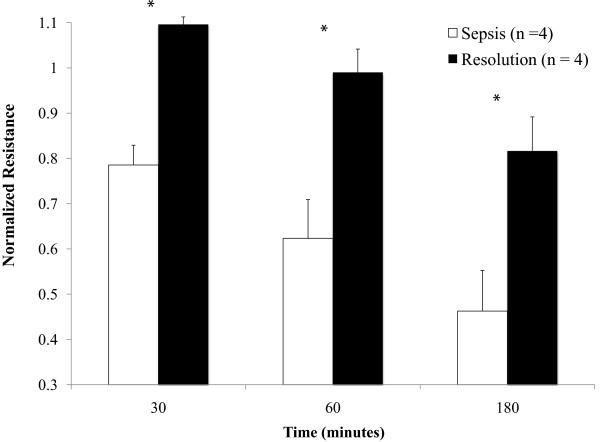
Resolution of sepsis leads to improved barrier function. Change in monolayer resistance at 30 minutes, 60 minutes, and 180 minutes. Groups were analyzed using two-way repeated-measures analysis of variance with Holm–Sidak post-hoc analysis. Values presented as mean ± standard error of the mean. The barrier-altering effect of neutrophils obtained once sepsis had resolved was significantly less than the effect of those obtained from the same patient during sepsis. *P <0.05.